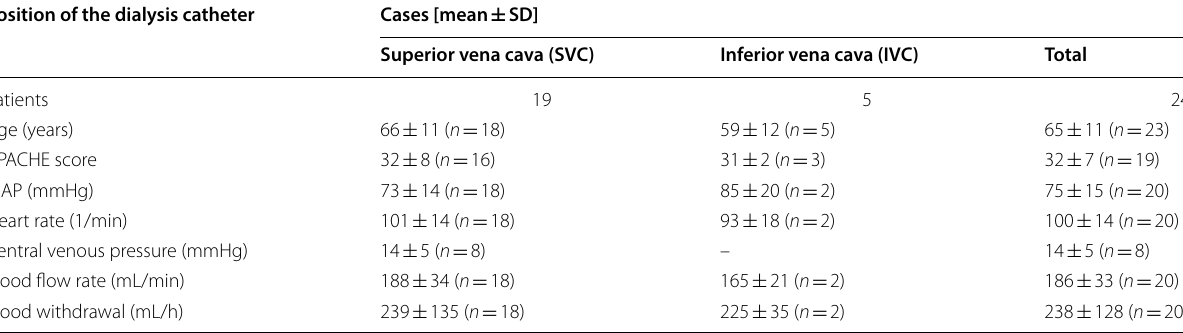
12 ( n 5) 65 ± = 2 ( n 3) 32 ± = 21 ( n 2) 186 ± = 35 ( n 2) 238 ± =